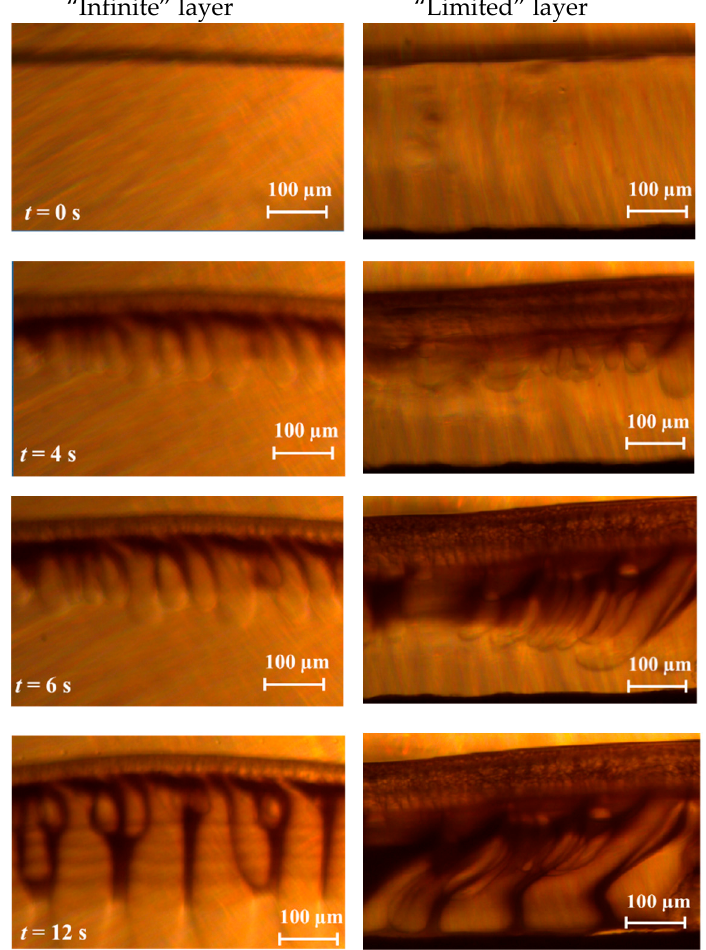
Figure 4. The precipitation kinetics of 12 wt.% solution of PAA in NMP upon contact with water; the thickness of polymer solution was about 2 cm (left) and 300 µ m